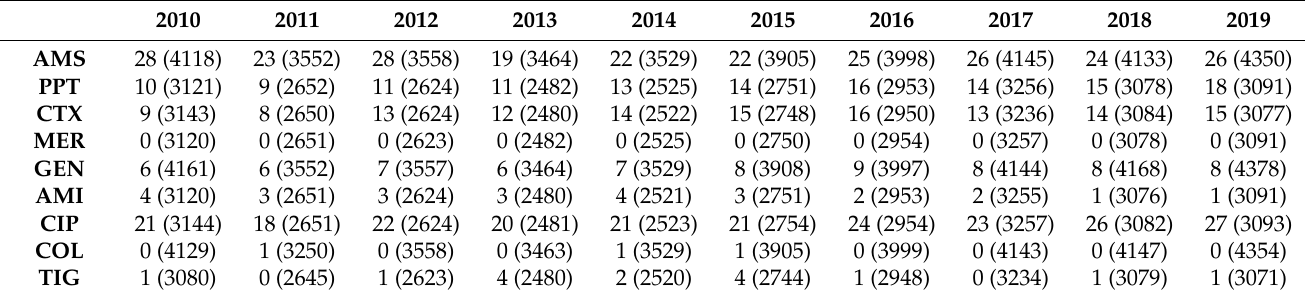
Table 3. Resistance of Escherichia coli to antibiotics at the University Hospital Olomouc in 2010–2019.